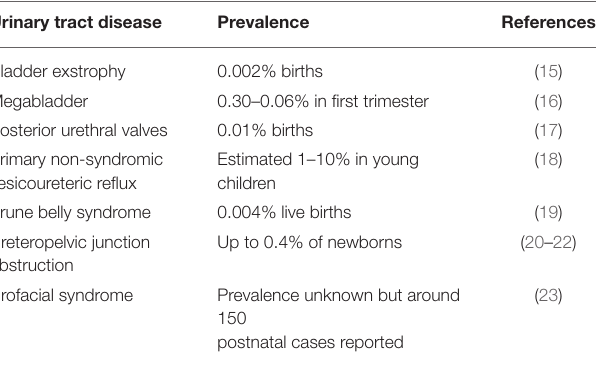
TABLE 1 | Prevalences of human congenital urinary tract diseases. Urinary tract